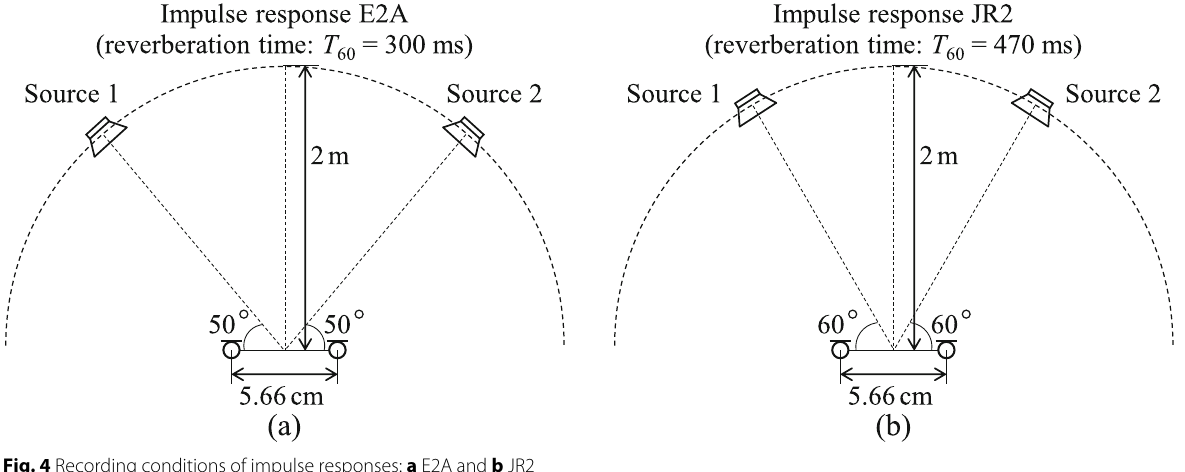
Fig. 4 Recording conditions of impulse responses: a E2A and b JR2